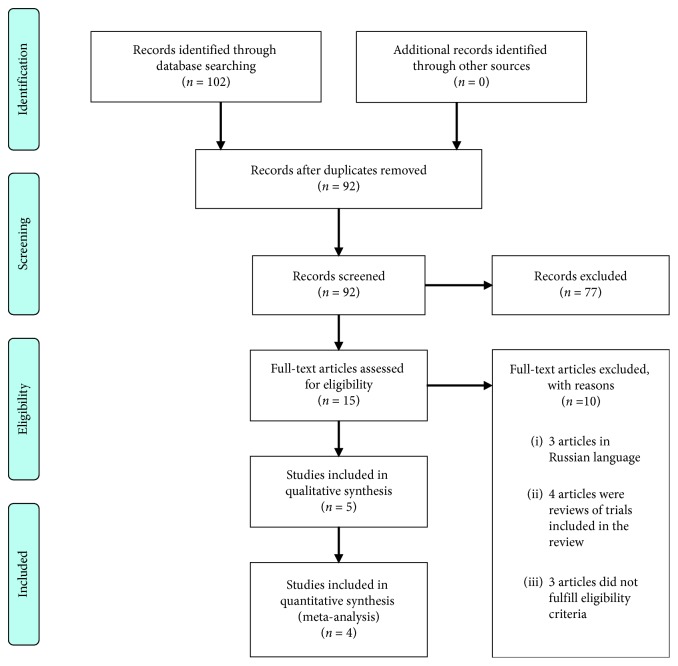
PRISMA flow diagram.